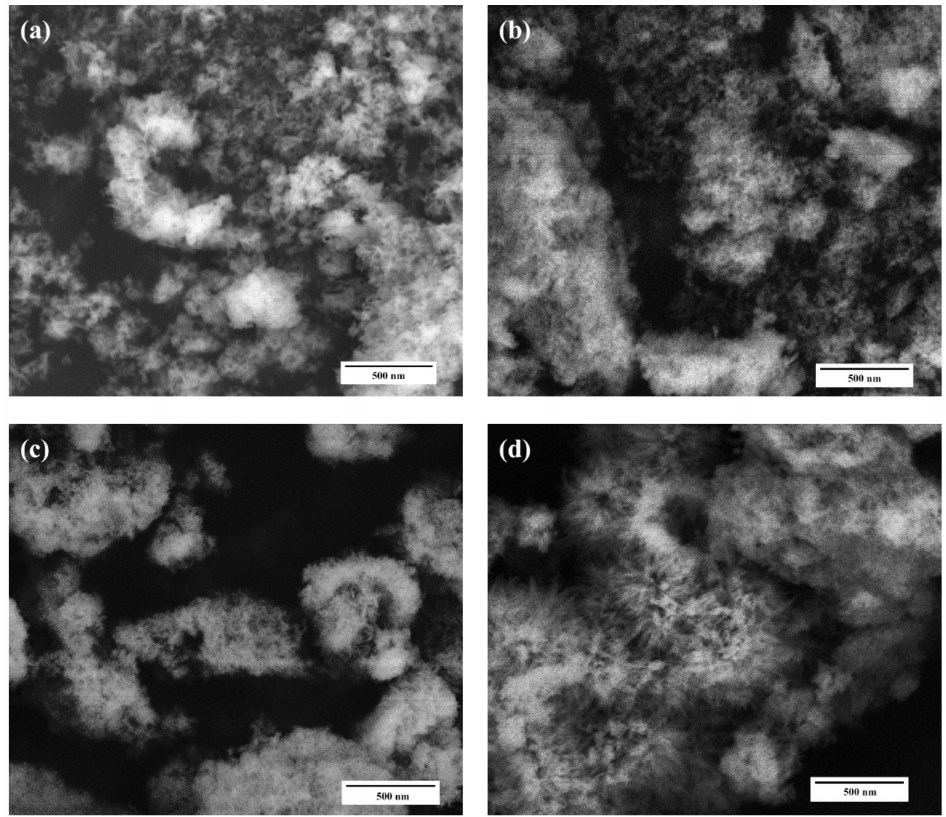
Figure 3. SEM microphotographs of the HA ( a ), Fe-HA3 ( b ), Fe-HA4 ( c ), Fe-HA7 ( d ) samples, magnification 50